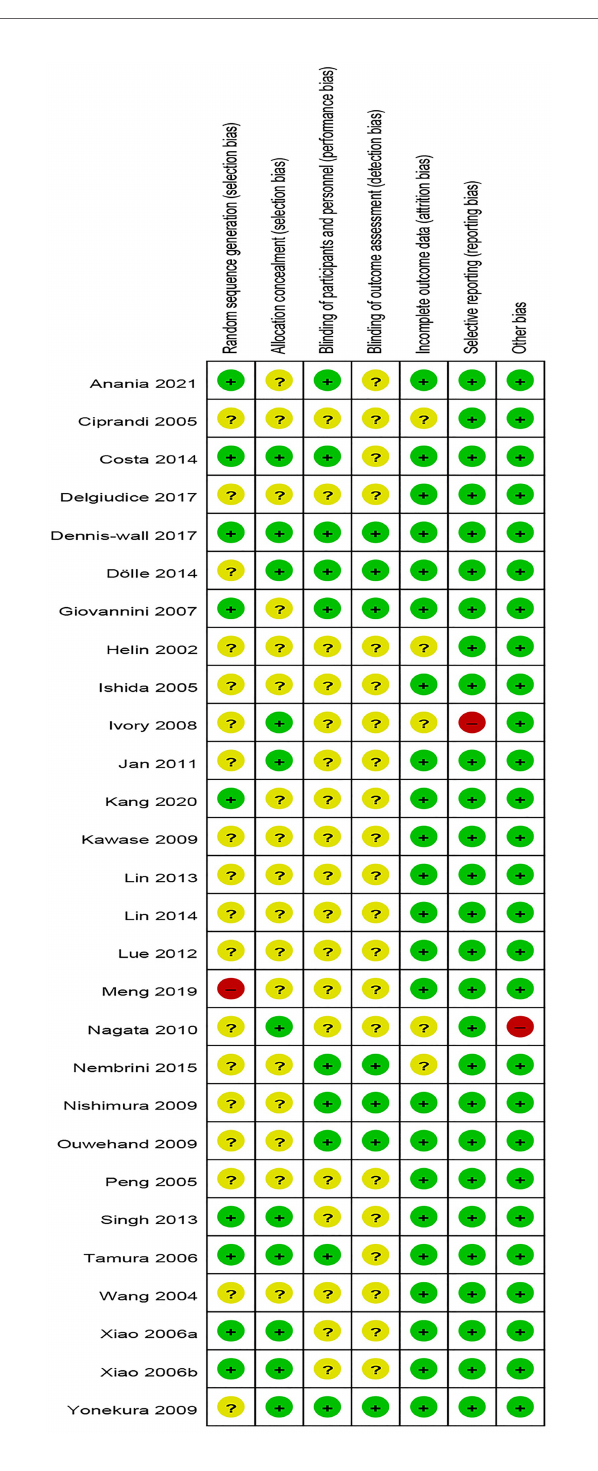
FIGURE 3 | Summary of risk of